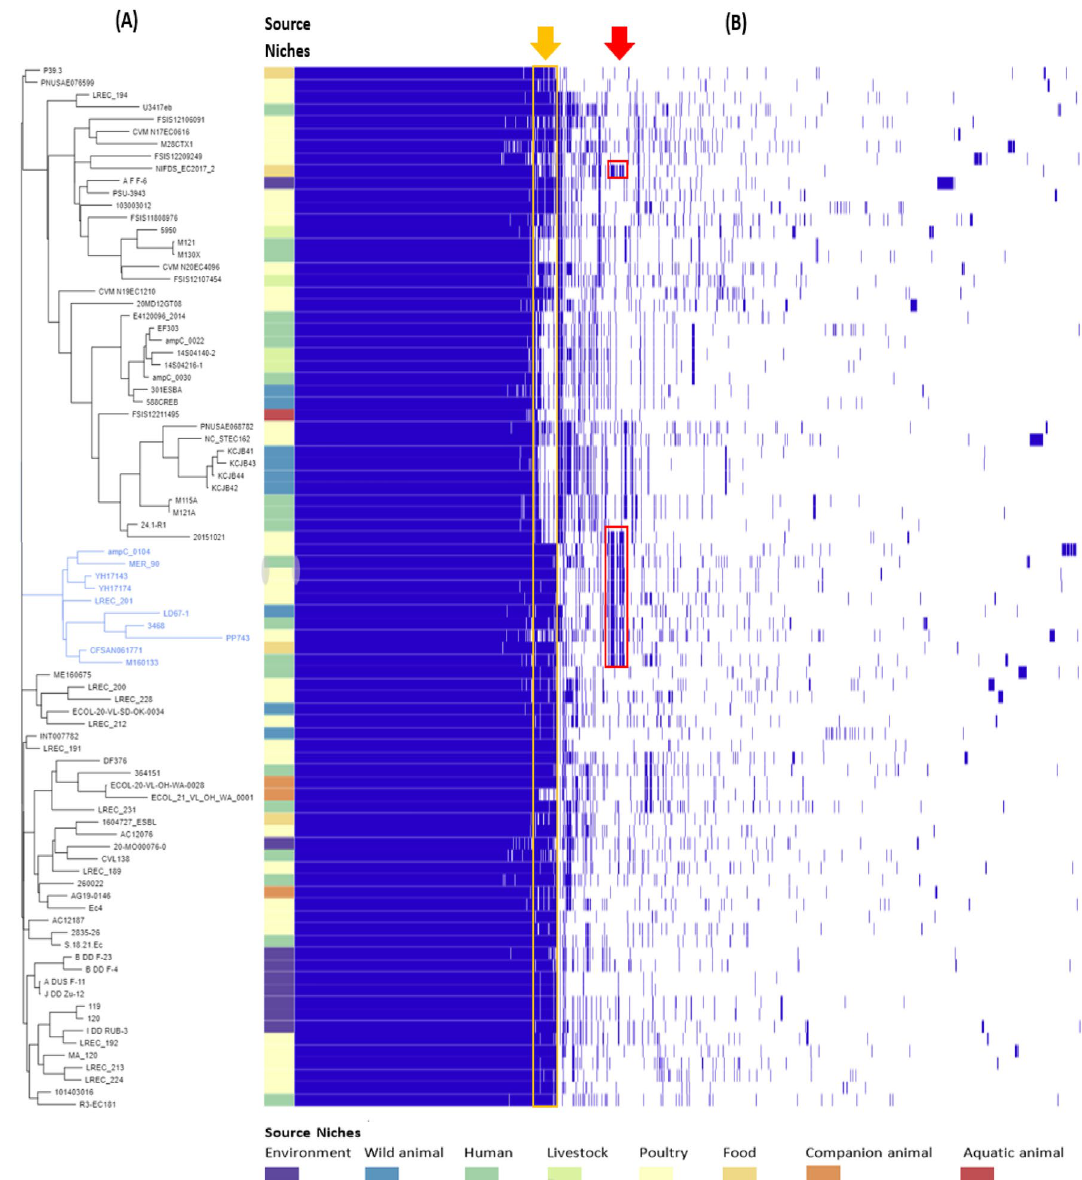
Figure 2. Pan-genome comparison of 85 E. coli ST1485 strains. ( A ) Phylogenetic tree constructed by FastTree 2 version 2.1.9 53 based on accessory genes. ( B ) Matrix plot, which shows the presence and absence of each gene across all strains by blue and white, respectively. A complete list of annotated genes is provided in the Supplementary Table 1. Red arrow refers to the pCFSAN061771_02 like plasmid genes that are outlined by red squares, while the orange arrow refers to pCFSAN061771_01 like plasmid genes that are outlined by orange square. Source niches are denoted with different colors. All strains in the clade containing the sequenced reference strain CFSAN061771 are given in